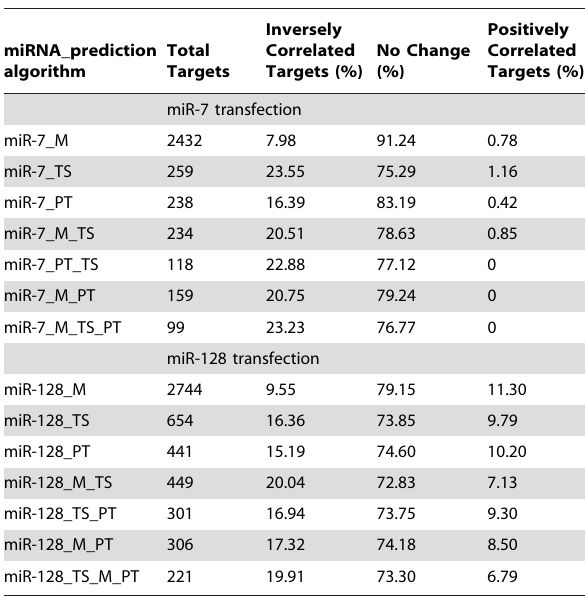
Table 5. Summary values of IC, PC and NC targets in transfection experiments using miRanda, TargetScan and PicTar target